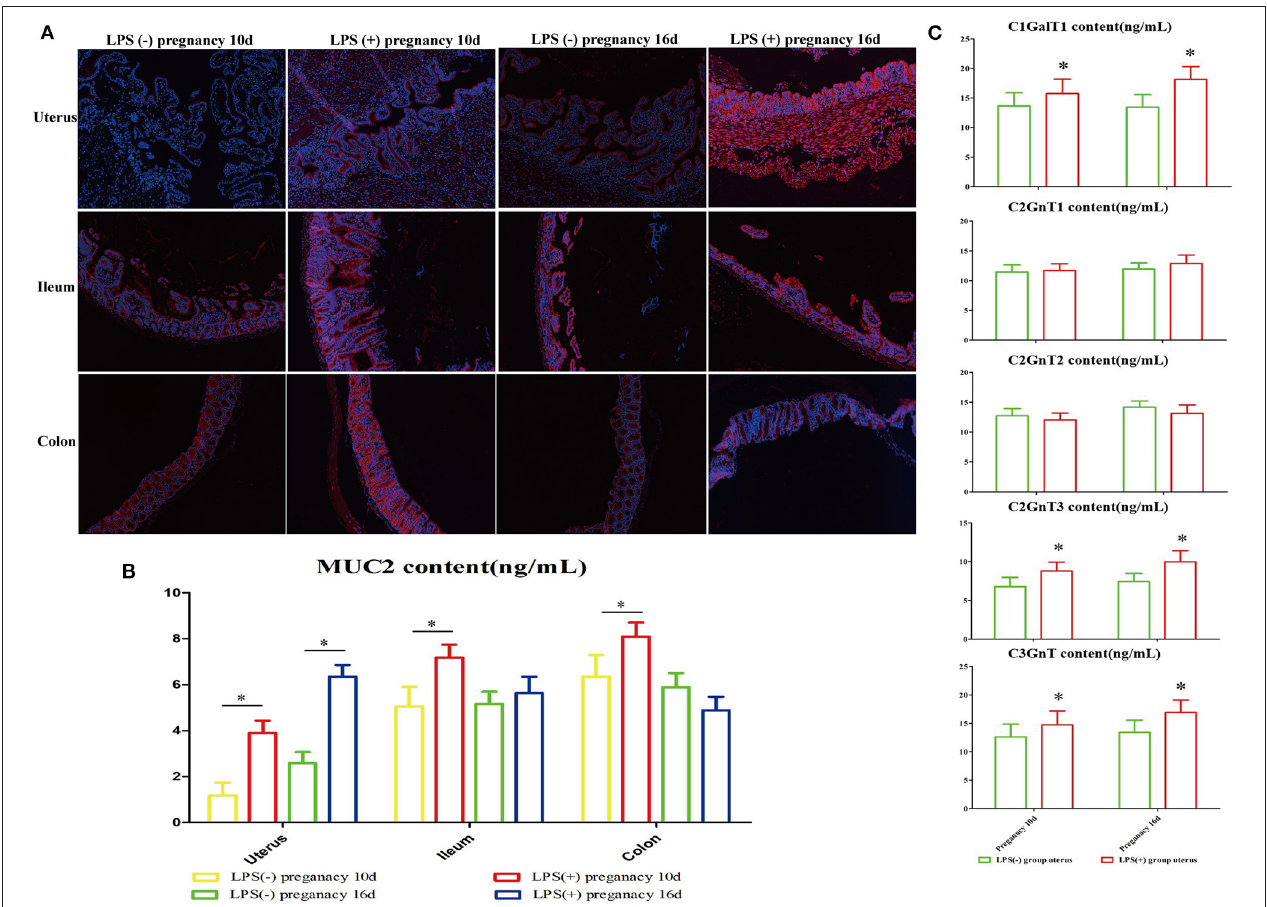
FIGURE 3 | The effect of LPS on the expression of MUC2 in the intestinal and reproductive system mucosa. (A) Immunofluorescence staining was used to detect the expression of MUC2 in the ileum, colon, and uterus. (B) Changes in MUC2 content in the ileum, colon, and uterus. (C) The effect of LPS on mouse glycosyltransferase activity in the uterus (C1GalT1, C2GnT1, C2GnT2, C2GnT3, C3GnT). * p < 0.05 indicates a significant difference between the LPS( + ) group and the LPS( − ) group during the same